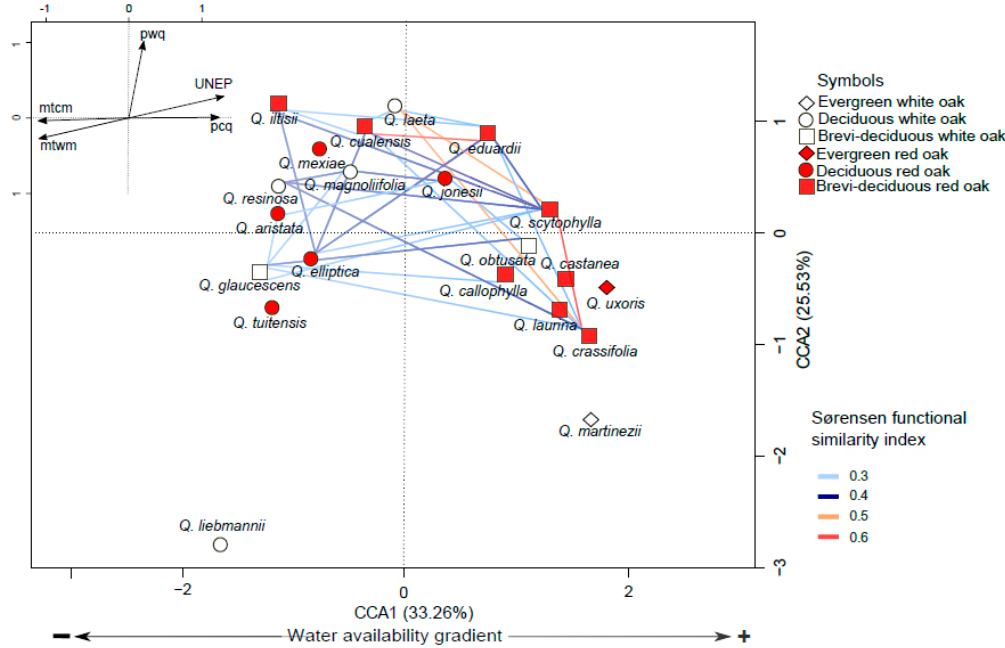
Figure 4. Sample ordination produced by canonical correspondence analysis. The vectors indicate the environmental variables. UNEP (United Nations Environment Programme) aridity index; mtwm (maximum temperature of warmest month); mtcm (maximum temperature of coldest month); pcq (precipitation of coldest quarter), and pwq (precipitation of warmest quarter). Lines indicate Sørensen functional similarity overlap ≥ 0.3 among oak species pairs.